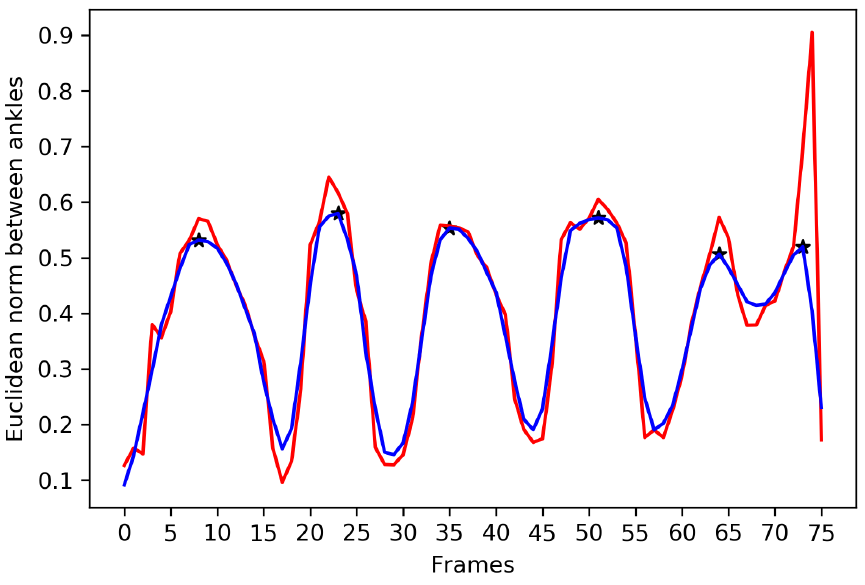
Figure 2. Euclidean norm between ankles is shown in red color. The result of noise reduction filters is shown in blue color. Local maxima is marked using the *